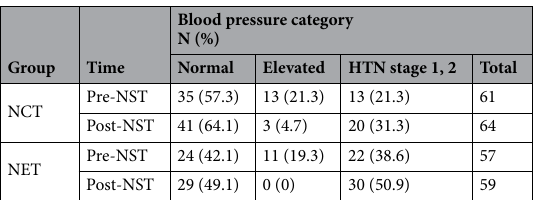
Table 5. Blood pressure category change after neoadjuvant treatment.